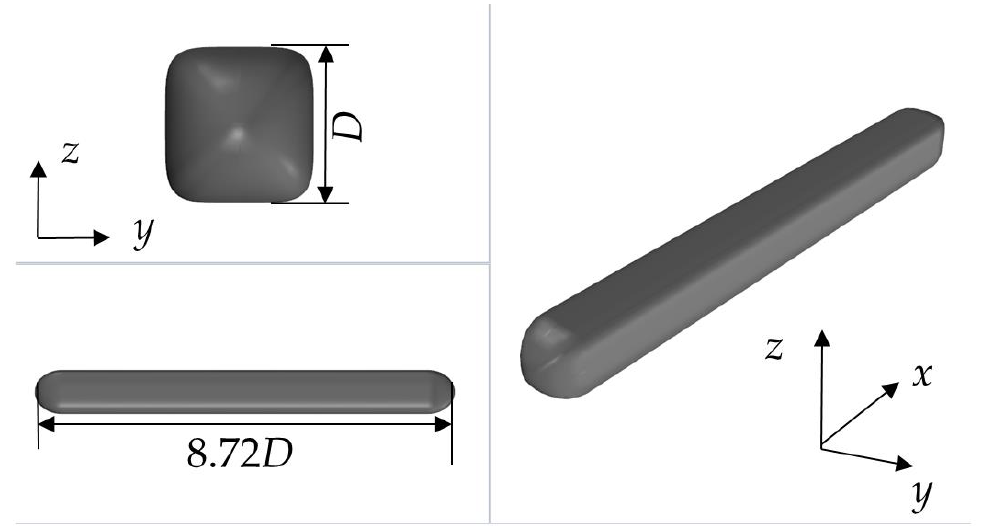
Figure 7. Generic train model.